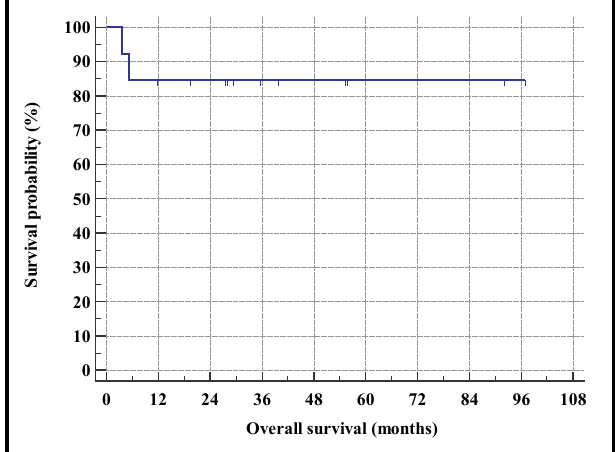
Figure 4: Kaplan-Meier curve of overall survival of